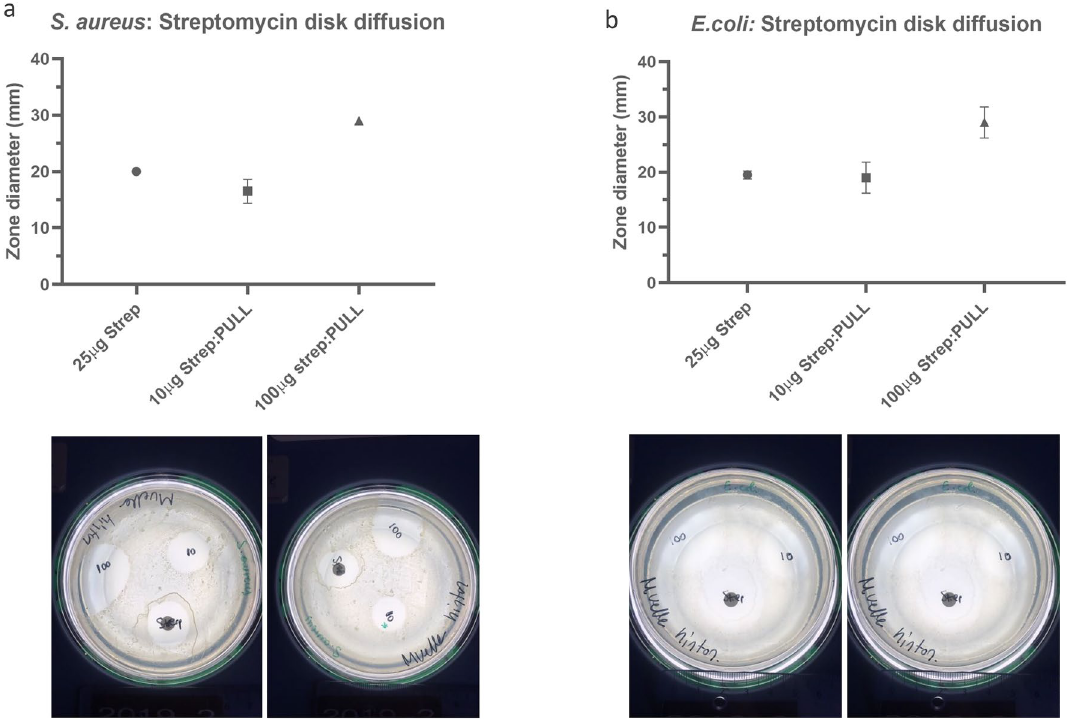
Figure 1. Disk diffusion assay. ( a ) S. aureus disk diffusion results of pullulan loaded with streptomycin and ( b ) E. coli disk diffusion results of pullulan loaded with